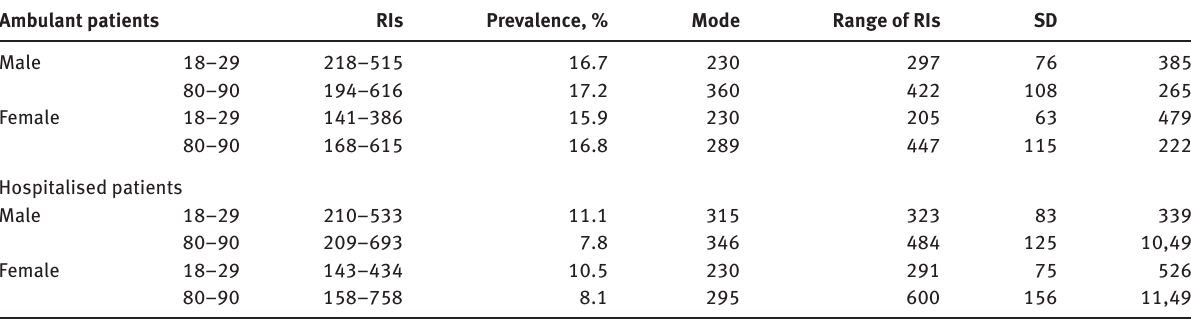
Table 2: Reference intervals of uric acid concentrations in heparinised plasma ( μ mol/L) with prevalence, mode, range and standard deviation (SD) of distribution, and number of contributing values (laboratory